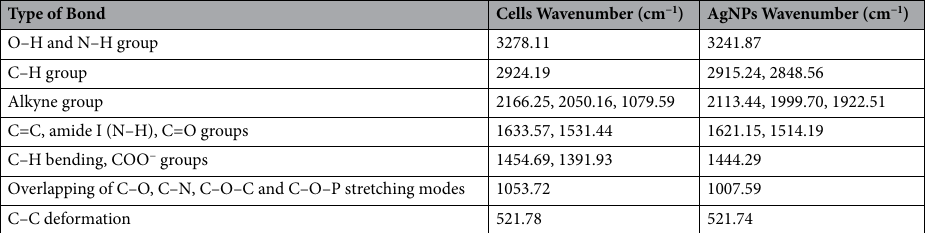
Table 1. Fourier transform-infrared spectroscopy (FT-IR) spectra of bacterial cell’s supernatant and AgNPs.